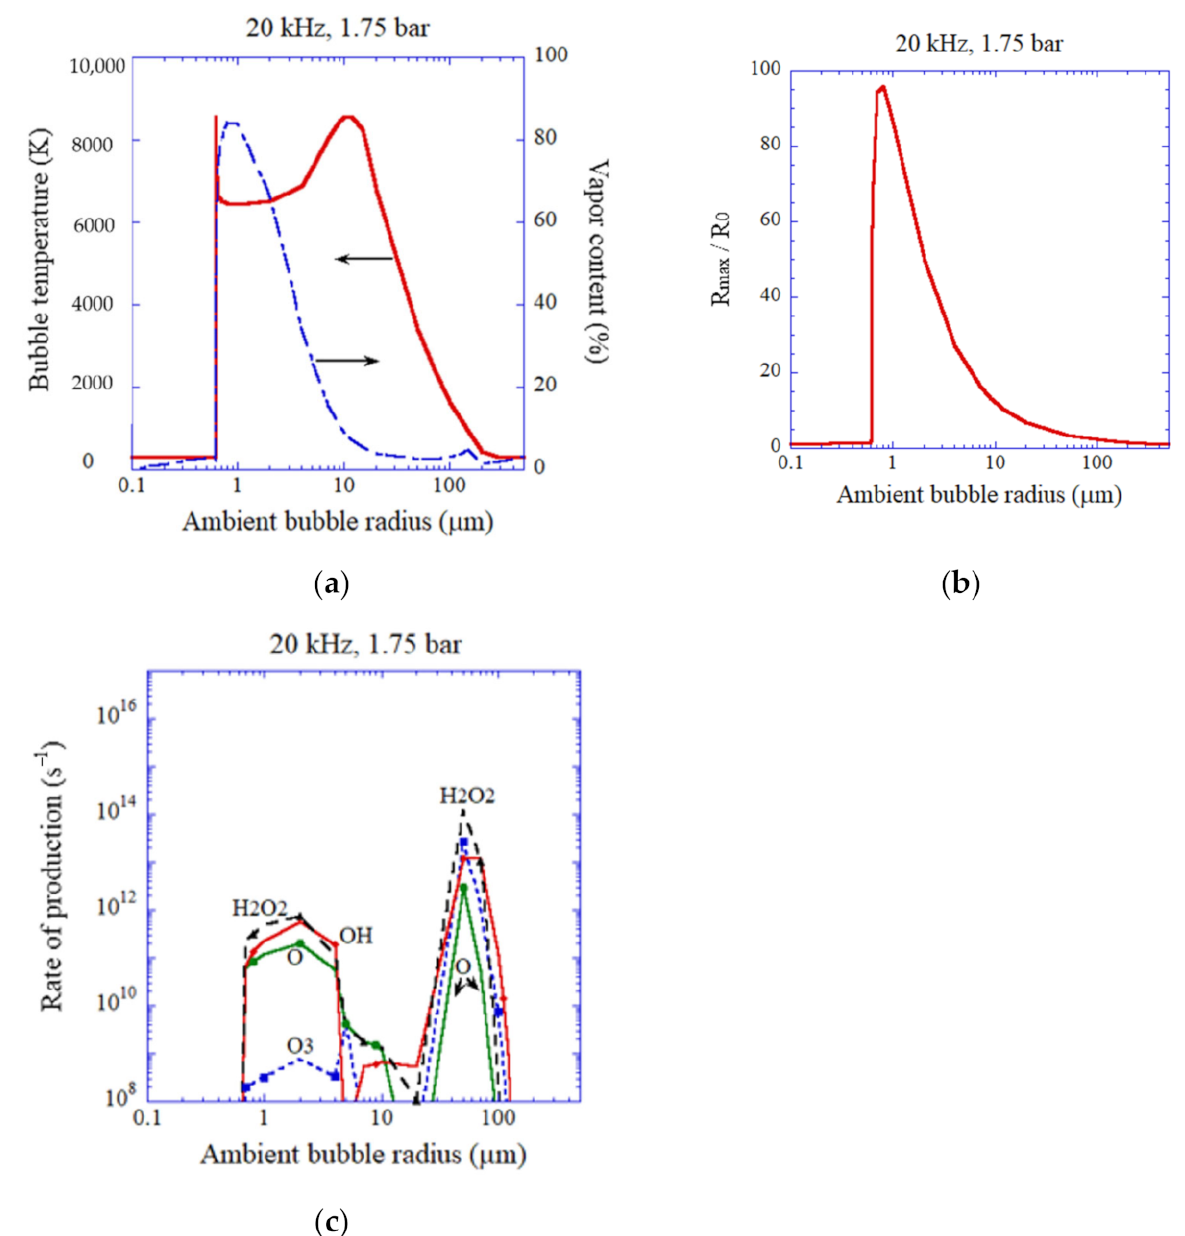
Figure 7. The results of the numerical simulations as a function of ambient bubble radius for an isolated air bubble when frequency and pressure amplitude of ultrasound are 20 kHz and 1.75 bar, respectively [59]. ( a ) The temperature inside a bubble and the molar fraction of water vapor at the violent collapse. ( b ) The expansion ratio. ( c ) The rate of production of each oxidant. Copyright 2008, with permission of AIP